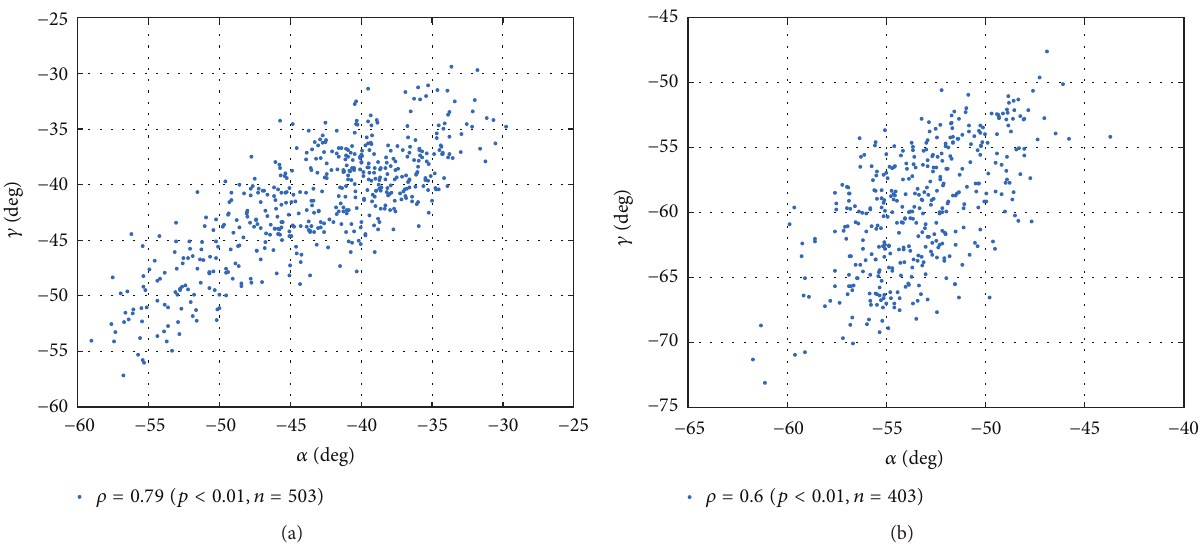
Figure 10: The presence of CD8 changes the relative movement of domains. (a) Scatter plot of Euler angles 𝛼 and 𝛾 between domains MHC 𝛼 𝛼 1 and 2 in the absence of CD8. (b) Scatter plot of the Euler angles